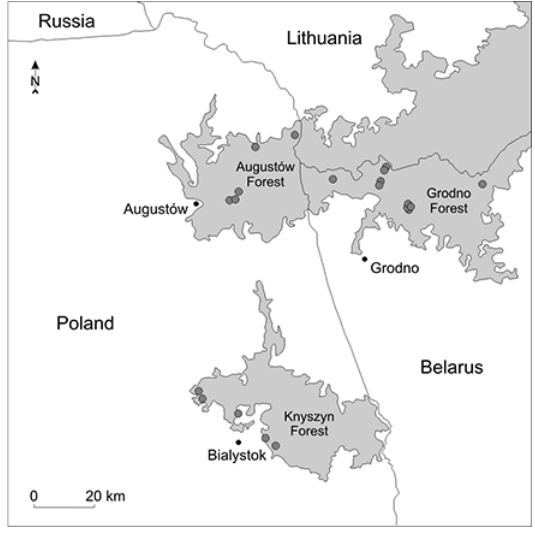
Fig. 1 Distribution map of the studied Arnica montana populations in mid-Eastern